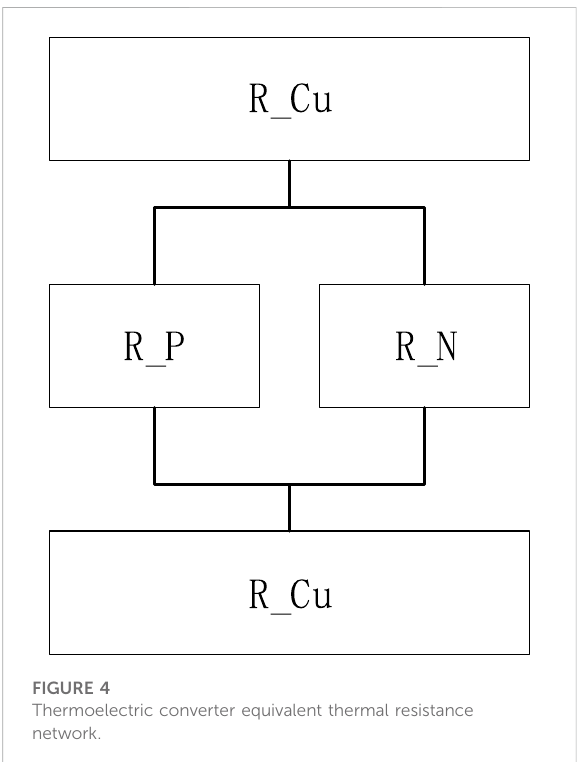
FIGURE 4 Thermoelectric converter equivalent thermal resistance